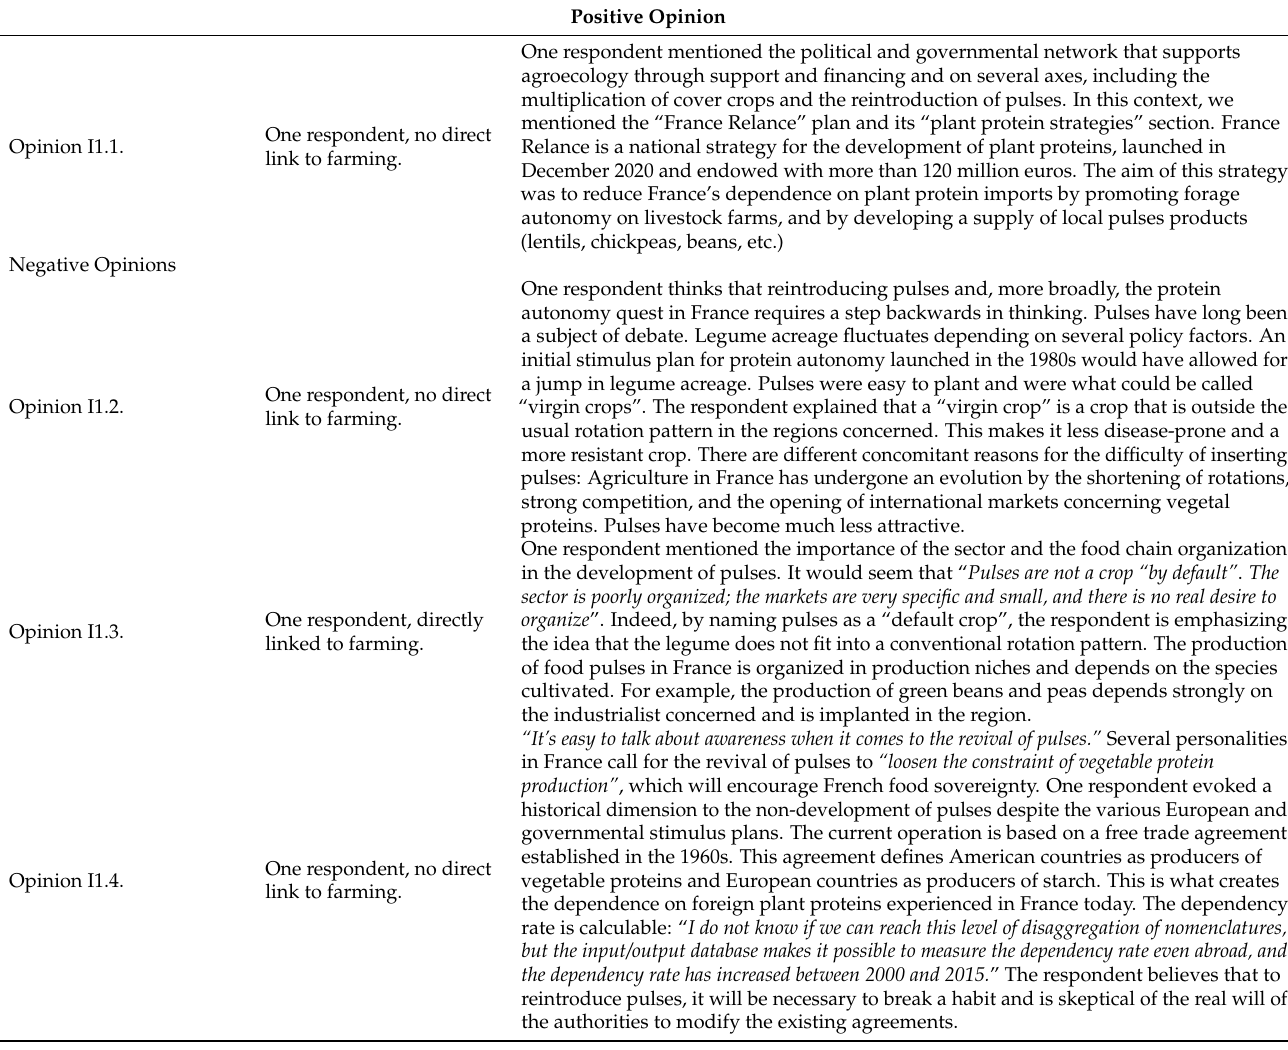
Table 6. Opinions concerning reintroducing pulses into the French cropping